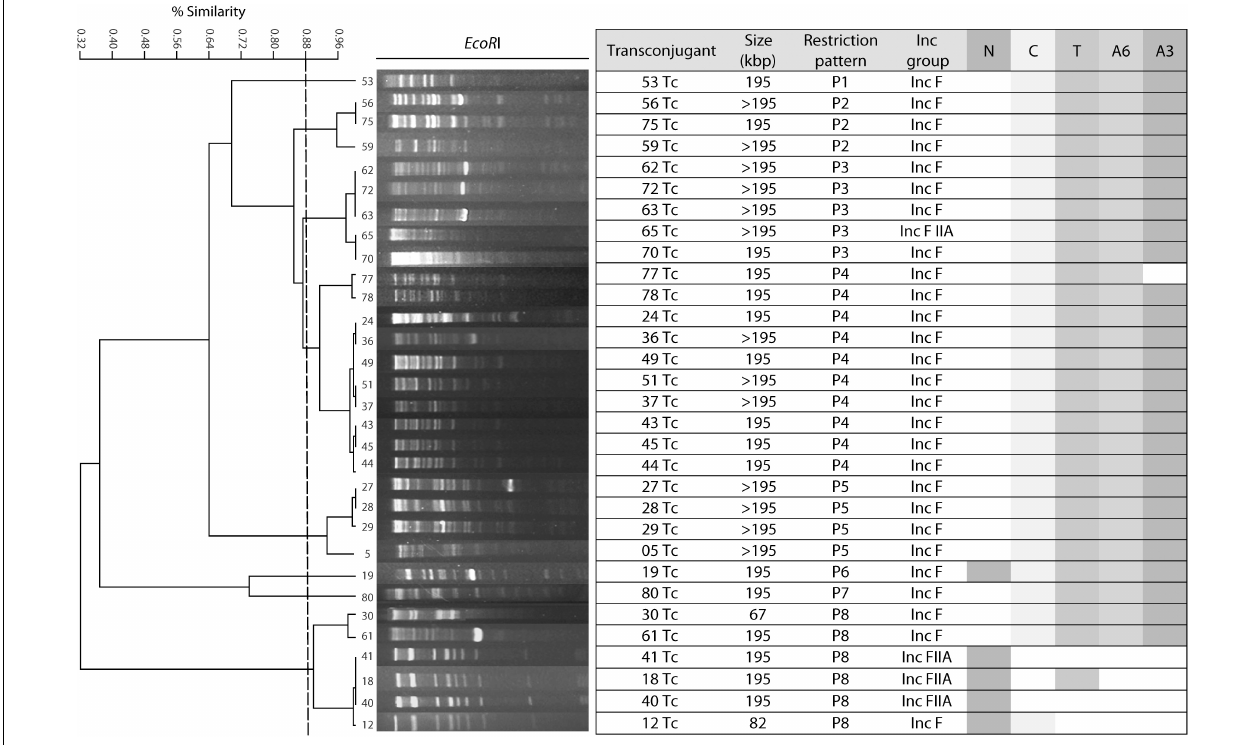
FIGURE 1 | Restriction fragment length polymorphism analysis of conjugative plasmids carrying antimicrobial resistance genes. N: bla NDM − 1 , C: bla CTX − M − 15 , T: bla TEM − 1 , A6: aac (6 (cid:48) )- Ib , A3: aac (3 (cid:48) )- IIa